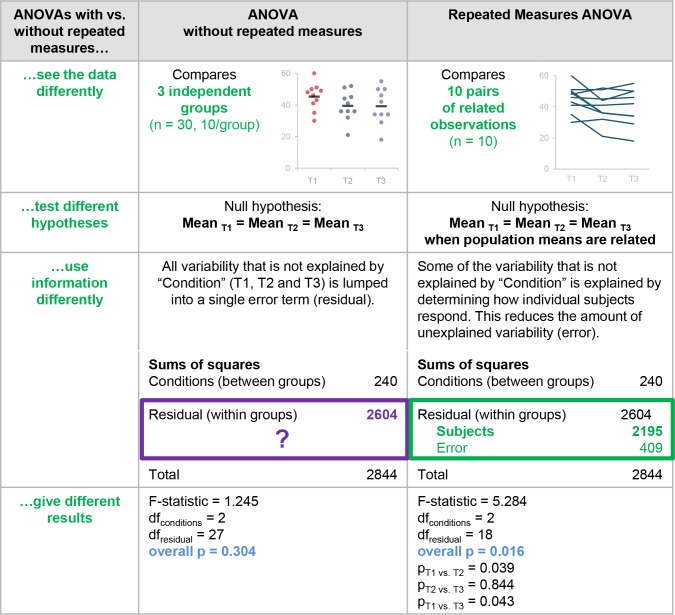
Why it matters whether investigators used an ANOVA with vs. without repeated measures.This figure highlights the differences between ANOVA with vs. without repeated measures and illustrates the problems with using an ANOVA without repeated measures when the study design includes longitudinal or non-independent measurements. These two tests interpret the data differently, test different hypotheses, use information differently when calculating the test statistic, and give different results.